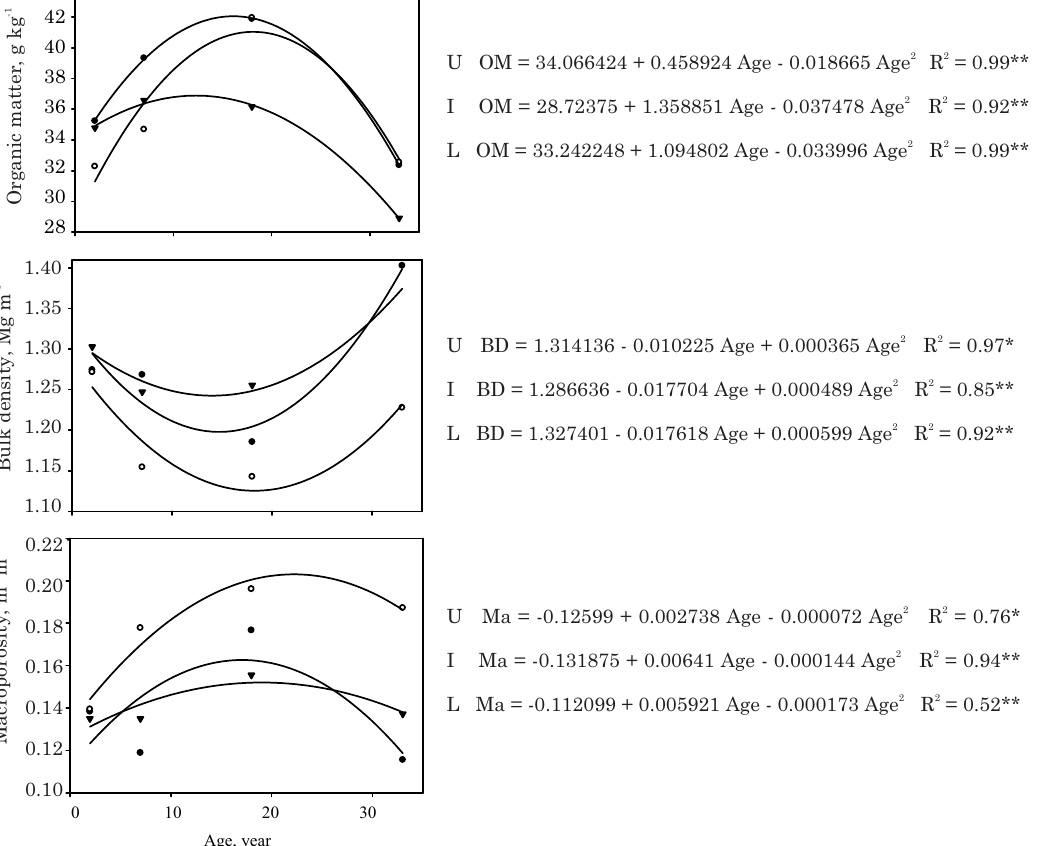
Figure 2. Effect of the interaction between age and sampling position on organic matter, bulk density and macroporosity (data are means of all three slopes and two depths). qqqqq Upper track (U), Inter-row (I) and lllll Lower track